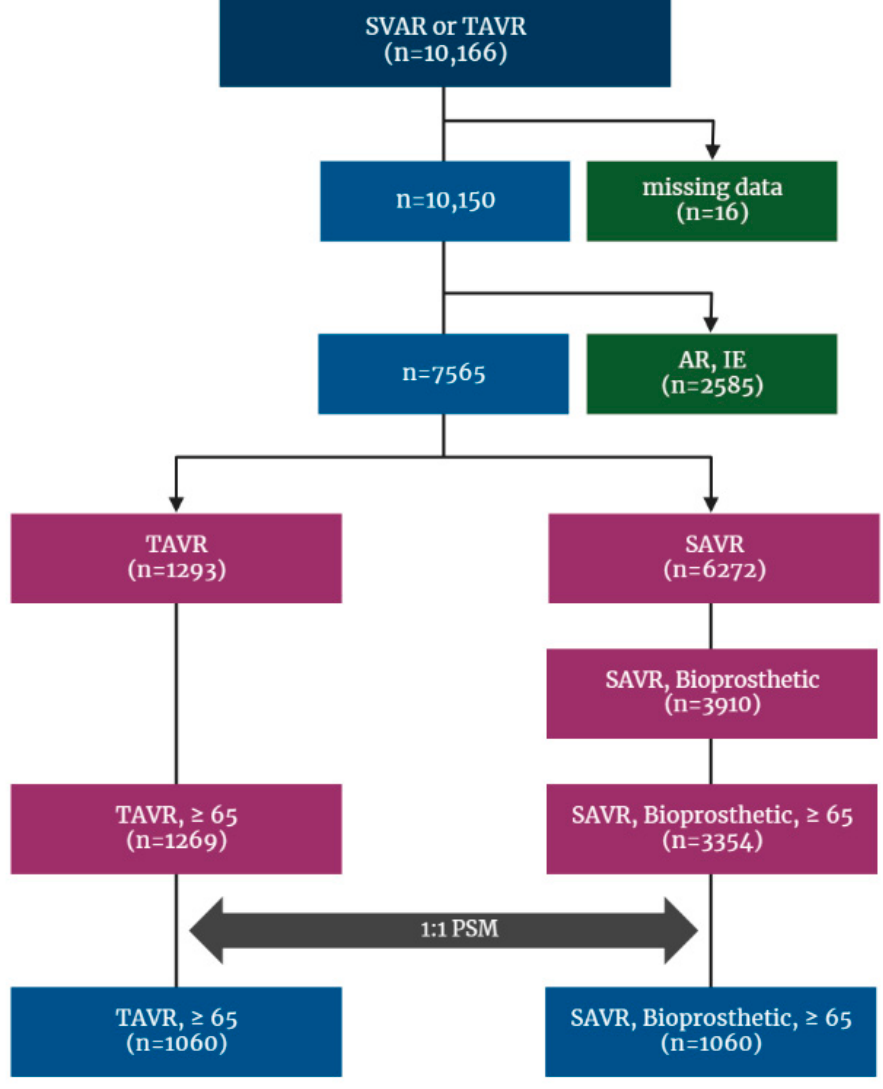
Figure 1. Flowchart for patient enrollment and exclusion. AR: aortic regurgitation; AS: aortic stenosis; IE: infective endocarditis; NHIS: National Health Insurance Service; PSM: propensity score matching; SAVR: surgical aortic valve replacement; TAVR: transcatheter aortic valve replacement. Baseline characteristics were measured to improve the comparability of both treat- ment groups. Demographic characteristics included age, sex, and clinical characteristics,